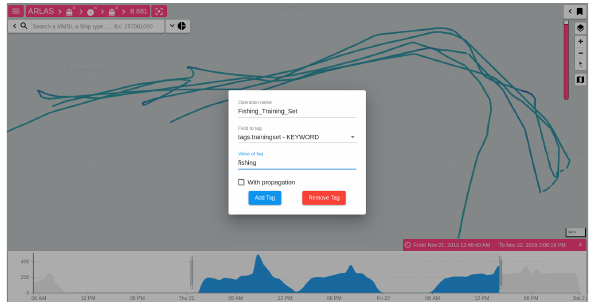
Figure 16 . Example of use of the labelling system for fishing detection